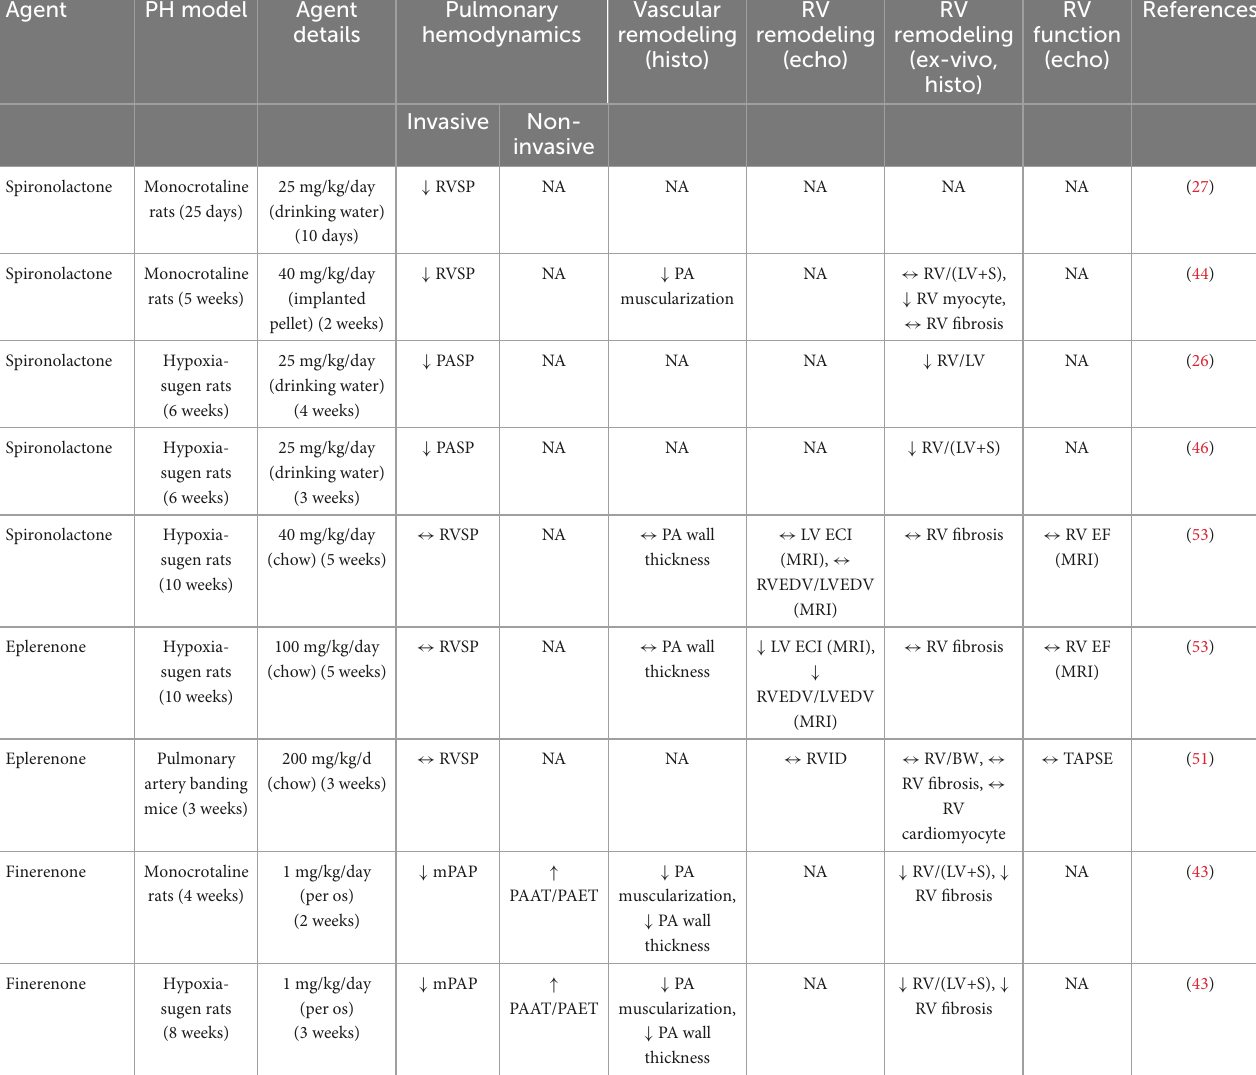
TABLE 2 Summary of studies evaluating the therapeutic application of mineralocorticoid receptor antagonists (MRAs) in rodent models of pulmonary hypertension (PH). Agent PH